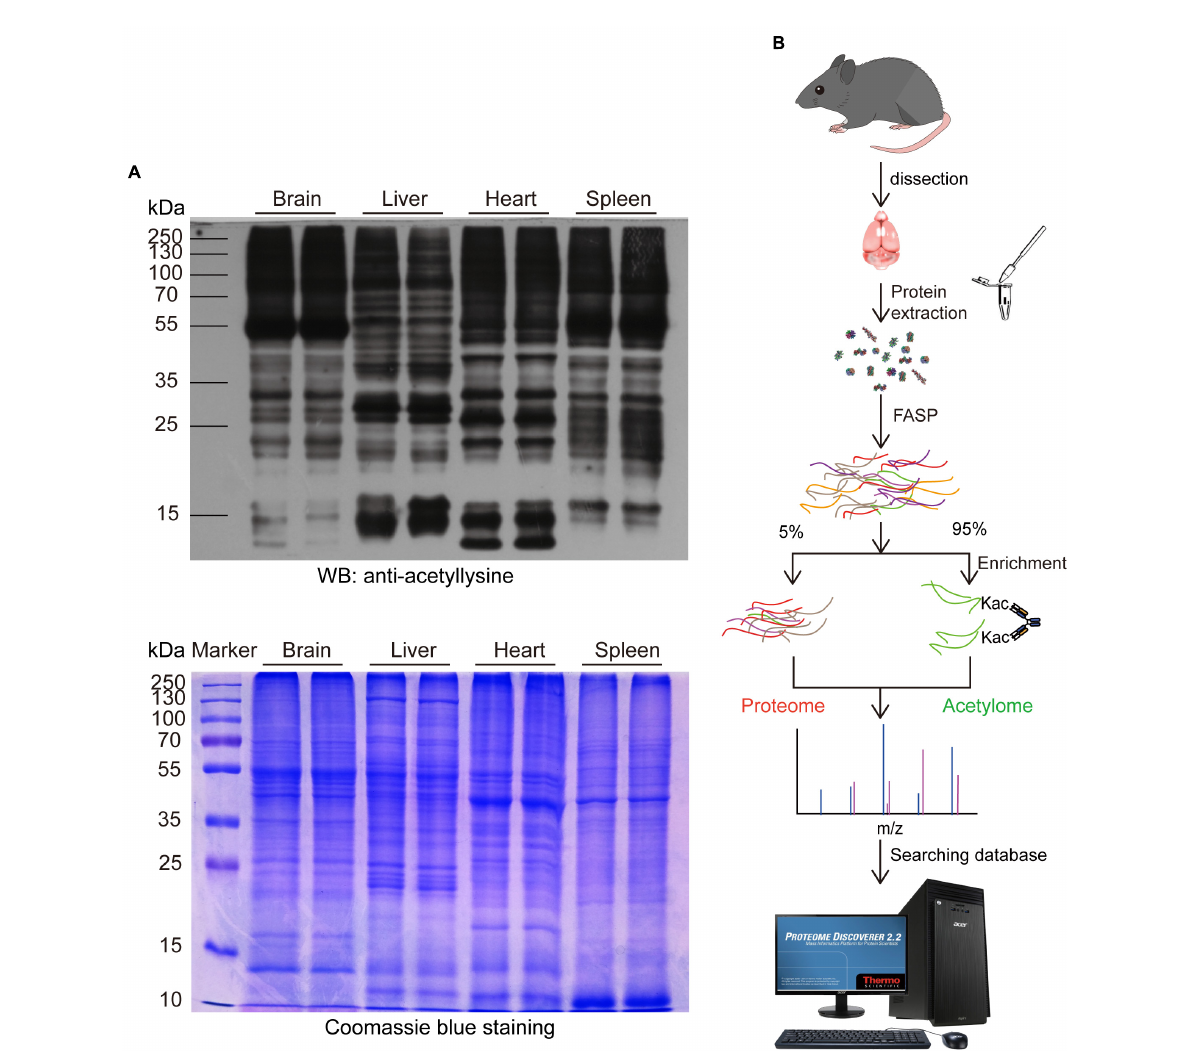
FIGURE1 Profiling the mouse brain acetylome by using a simplified workflow. (A) Comparing the expression pattern of lysine-acetylated proteins in the mouse brain, liver, heart, and spleen. 30 µ g proteins from the mouse brain, liver, heart, and spleen were separated by SDS-PAGE and probed with an anti-acetyllysine antibody (upper). Coomassie brilliant blue-stained SDS-PAGE was used as a loading control (Lower). (B) Schematic diagram depicting the simplified workflow for profiling mouse brain acetylome.